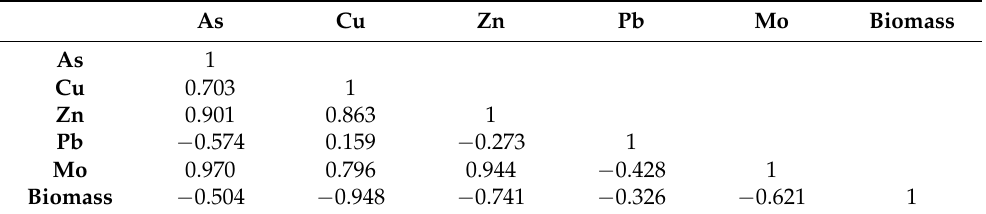
Table 2. Pearson’s coefficients of correlations between HMs and between HMs and invertebrate biomass. As Cu Zn Pb Mo Biomass As 1 Cu 0.703 1 0.901